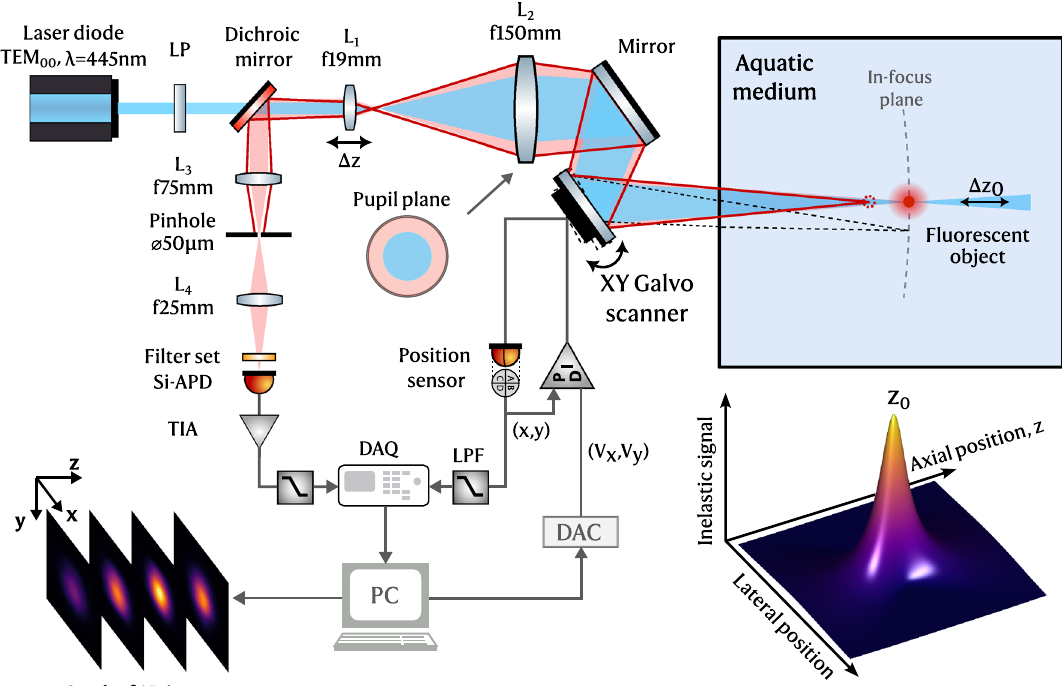
Figure 1. Schematic diagram of the implemented inelastic confocal LiDAR focused at an underwater probing distance z 0 . A tridimensional representation of the detected signal as a function of the axial and radial (lateral) position relative to the focal plane is